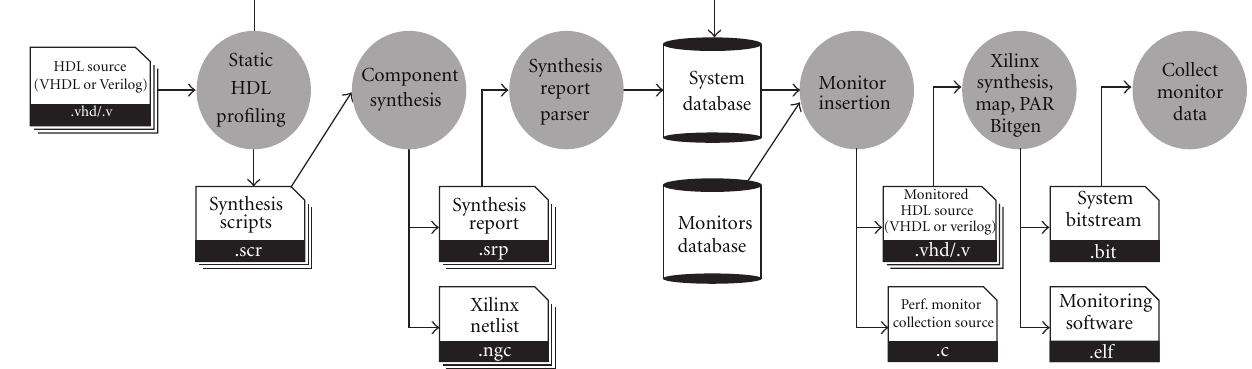
Figure 2: Hardware Performance Monitoring Infrastructure’s Tool Flow.